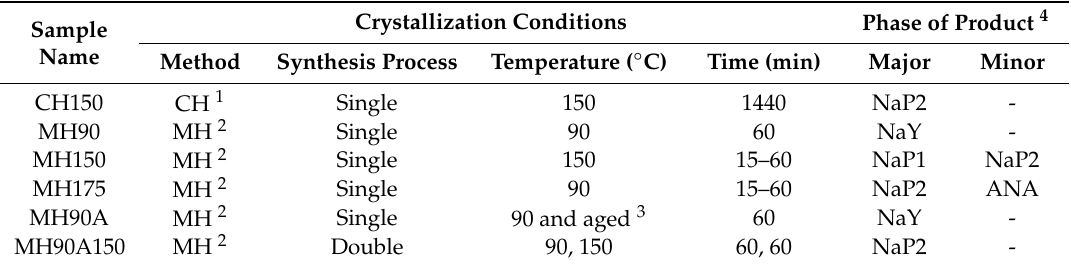
Table 3. Gel composition, synthesis parameters and phase of the products in this study.